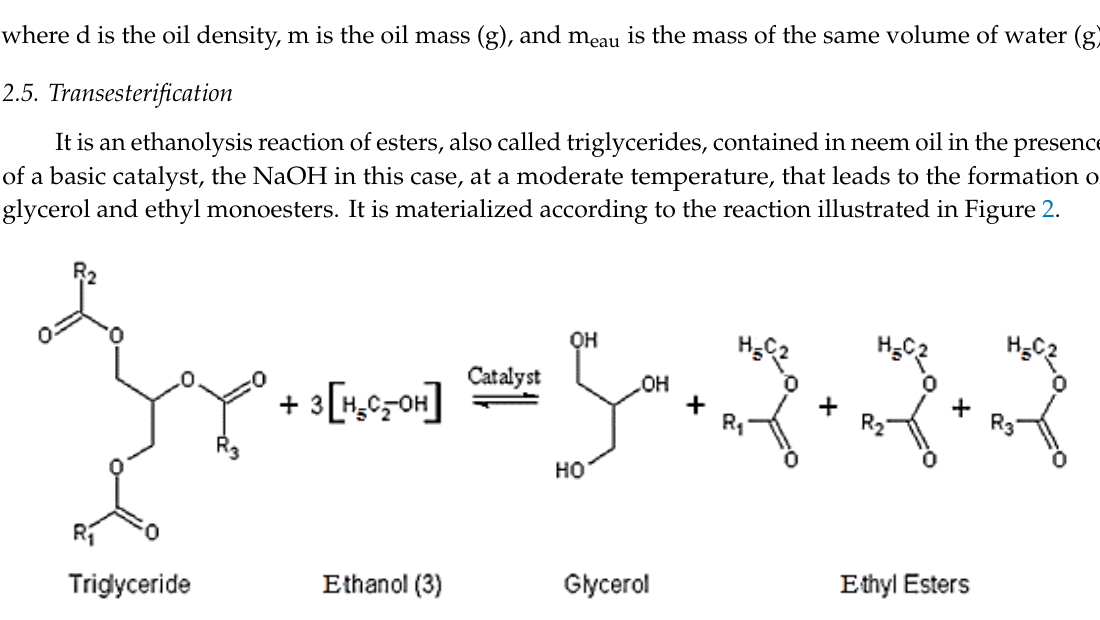
Figure 2. Transesterification reaction principle [12].